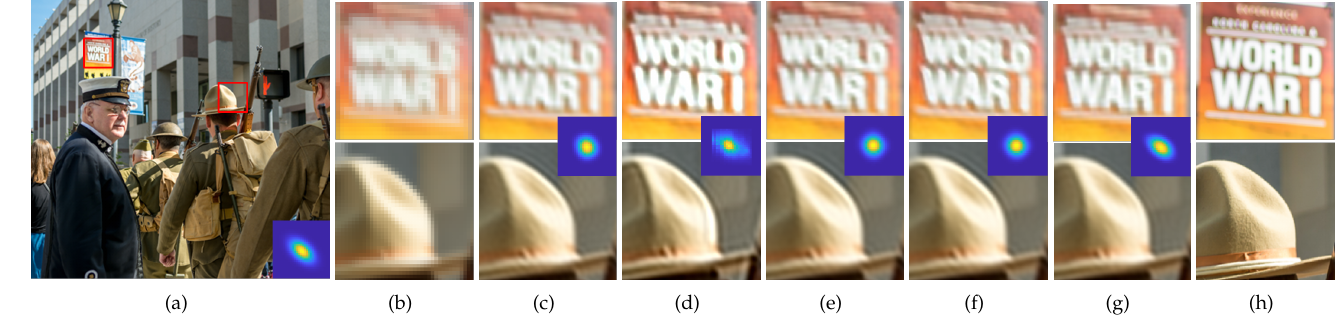
Figure 11. SR results of the 34th image of Flickr2KRK dataset using the estimated kernels for scale factor of × 4. The first row is the ZSSR results and the second row is the results of solving Equation (2). From ( c ) to ( g ), the estimated kernels are shown in the middle of each column. ( a ) GT image and kernel, ( b ) LR, ( c ) KernelGAN [20], ( d ) FKP [21], ( e ) E-KernelGAN [22], ( f ) E-KernelGAN-DIP [22], ( g ) TVG-KernelGAN, ( h ) GT.